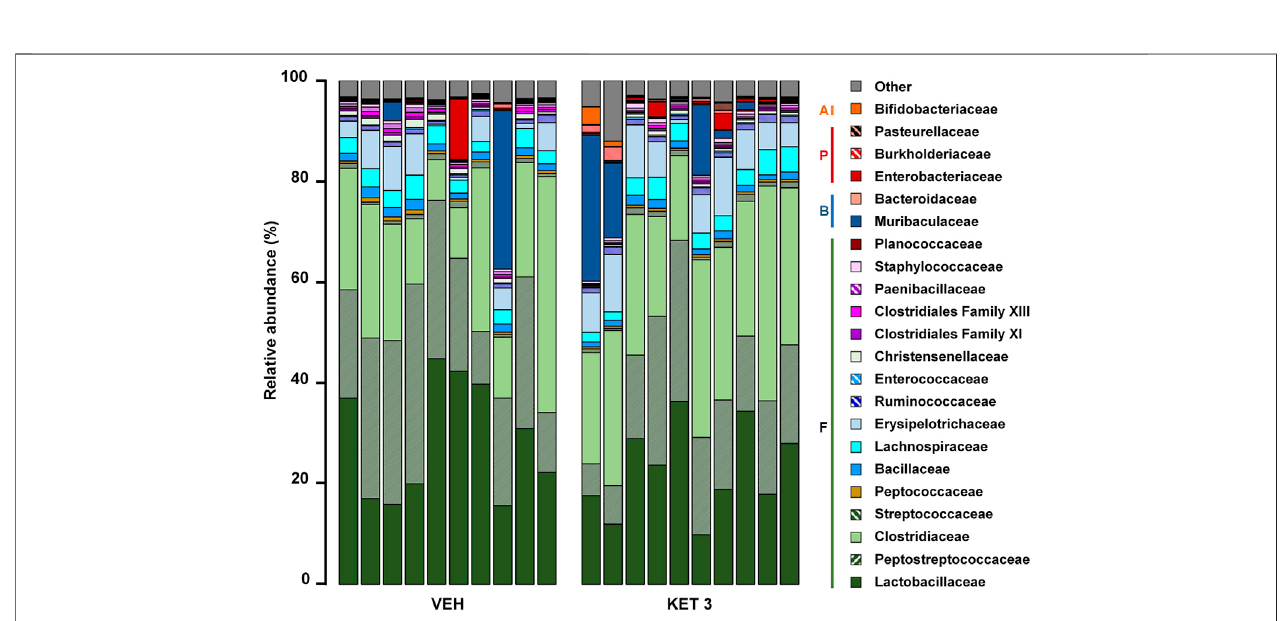
FIGURE3 | The relative abundance of bacterial familiesin jejunal samples ofrats treated with vehicle (VEH) or ketorolac (KET, 3 mg/kg) forfour weeks, determined by sequencing of 16 S rRNA. Each vertical bar represents the sequencing data for one rat. Unclassi fi ed families and families with an abundance less than 0.1% are summarized as “ Other. ” Abbreviations: F: Firmicutes, B: Bacteroidetes, P: Proteobacteria, A: Actinobacteria.